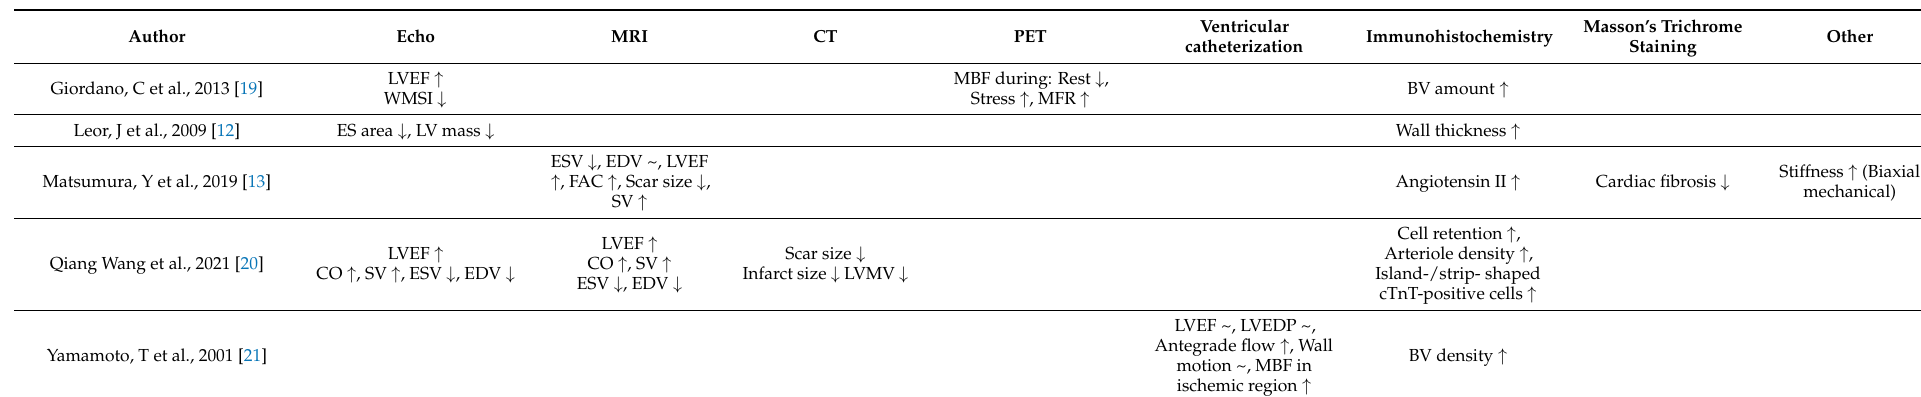
Table 2. Summary of outcome assessment—improved cardiac function in treatment groups with